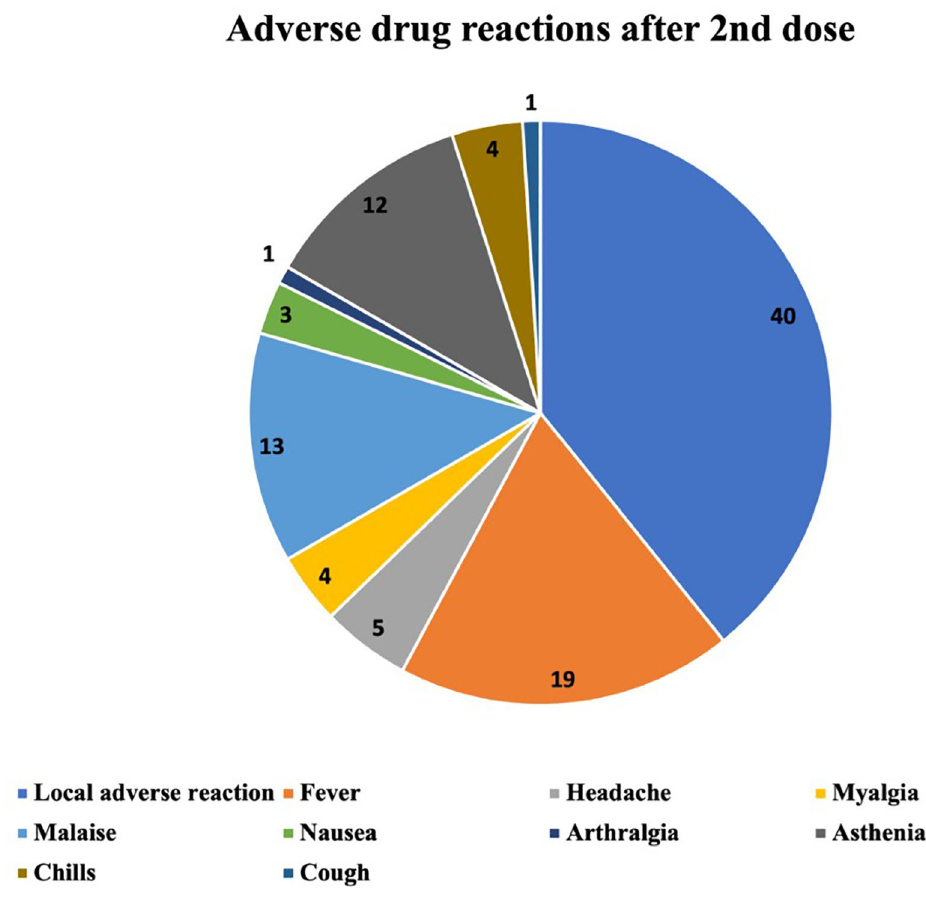
Figure 3. Number and type of adverse drug reactions after 2nd